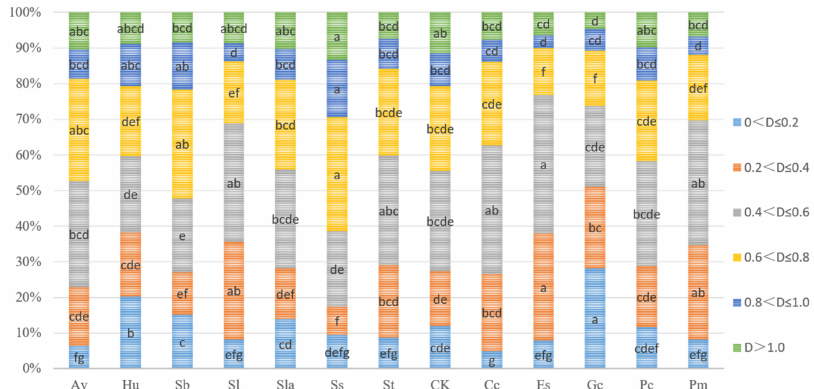
Figure 2. Percentage of root length in different diameter classes measured in roots colonized by different ECMF and DSE. Means labeled with different letters within each series are significantly different ( p < 0.05, n = 5) by Duncan’s test. Av, Hu, Sb, Sl, Sla, Ss, and St represent P. tabulaeformis seedlings were inoculated with ECMF of A. vaginata , H. utriformis , S. bovinus , S. lactifluus , S. laricinus , Schizophyllum sp., and S. tomentosus ECMF, respectively; Cc, Es, Gc, Pc, and Pm represent the P. tabulaeformis seedlings were inoculated with DSE of C. cladosporioides , E. salmonis , G. cylindrosporus , P. chrysanthemicola , and P. mustea , respectively; and CK as the control group; D represents the diameter of the root.